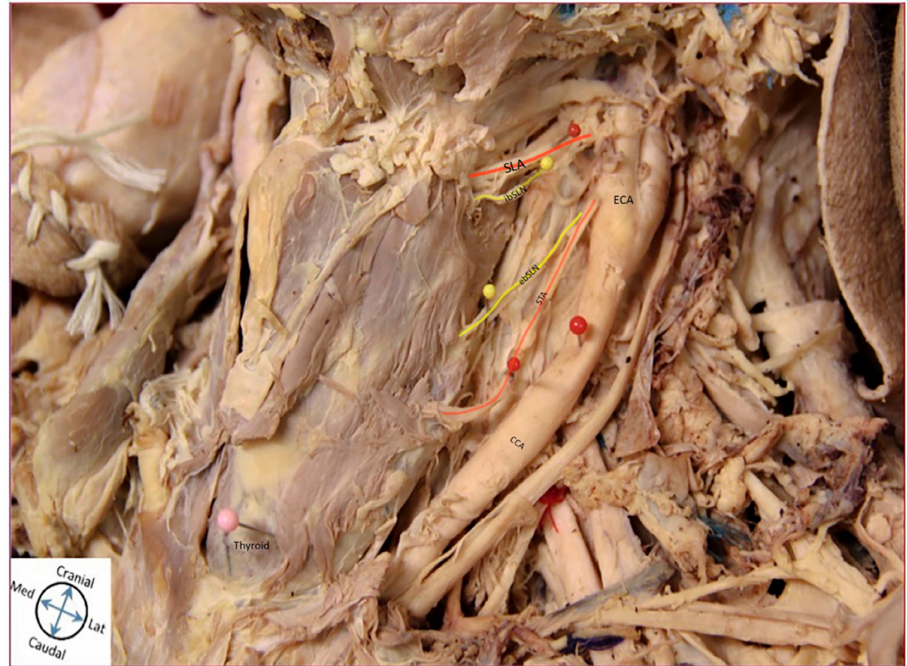
Figure 5. Cadaveric Representation of Anatomical Relationships. Cadaveric Image Representing Anatomical Relationship of External Laryngeal Nerve (ebSLN) and the Superior Thyroid Artery (STA) and Internal Laryngeal Nerve (ibSLN) with the Superior Laryngeal Artery (SLA). The image shows the ebSLN traveling anteromedial relative to the STA. The ibSLN travels inferoposterior relative to the SLA, which is directly branching off the ECA. Abbreviations: ebSLN, external laryngeal nerve; ibSLN, internal laryngeal nerve; CCA, common carotid artery; ECA, external carotid artery; STA, superior thyroid artery; SLA, superior laryngeal